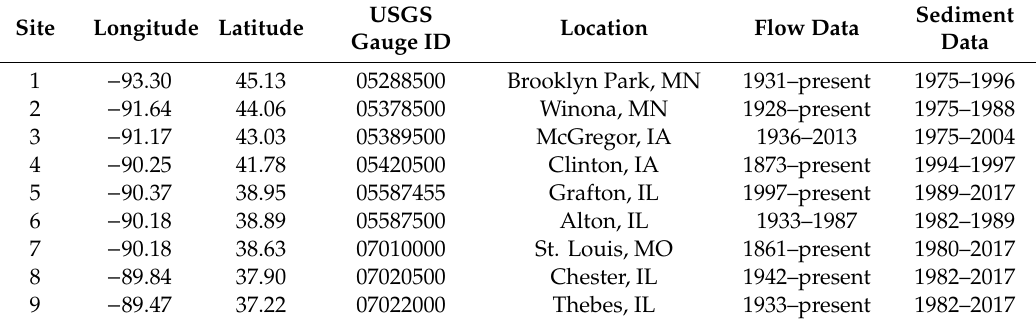
Table 1. General information and periods of available flow and sediment data (both suspended sediment concentration (SSC) and sediment discharge) for the nine Upper Mississippi River study sites shown in Figure 1. Source: https://waterdata.usgs.gov/nwis/.